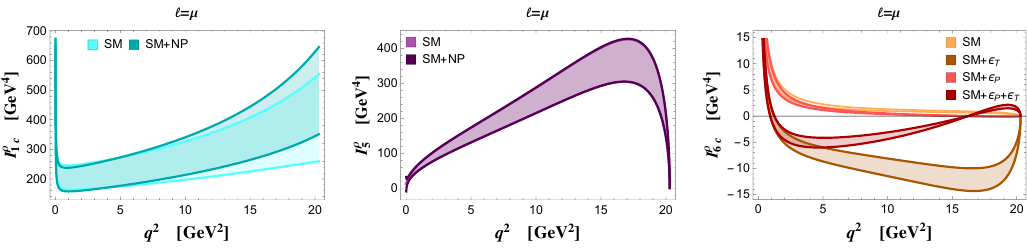
( q 2 ) ( left ), I ρ ( q 2 ) ( middle ) and I ρ 5 1 c